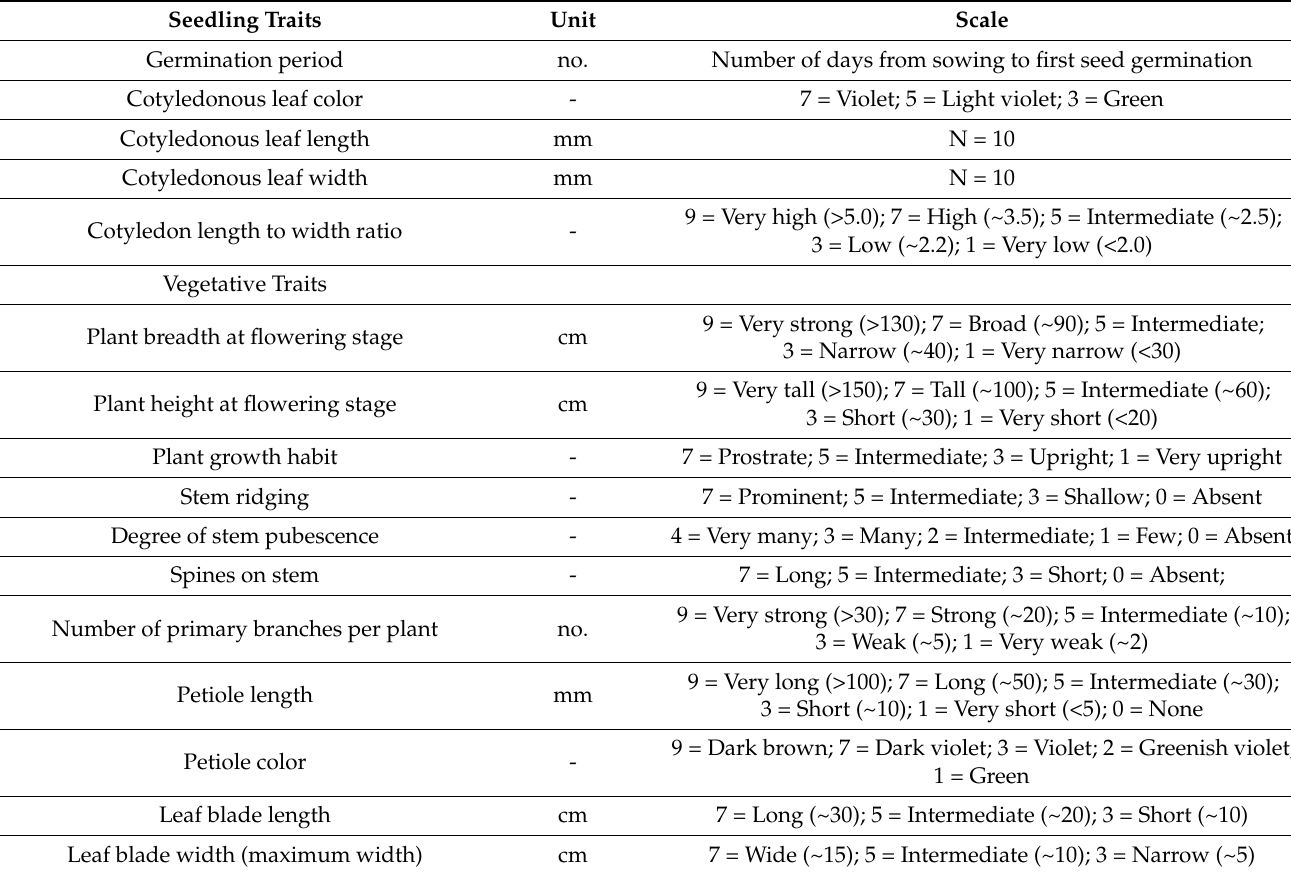
Table 4. Standard eggplants descriptors for seedlings, vegetative, inflorescence, seed, and fruits traits adapted from the International Board for Plant Genetic Resources [50] and the World Vegetable Centre [36]. Seedling Traits Unit